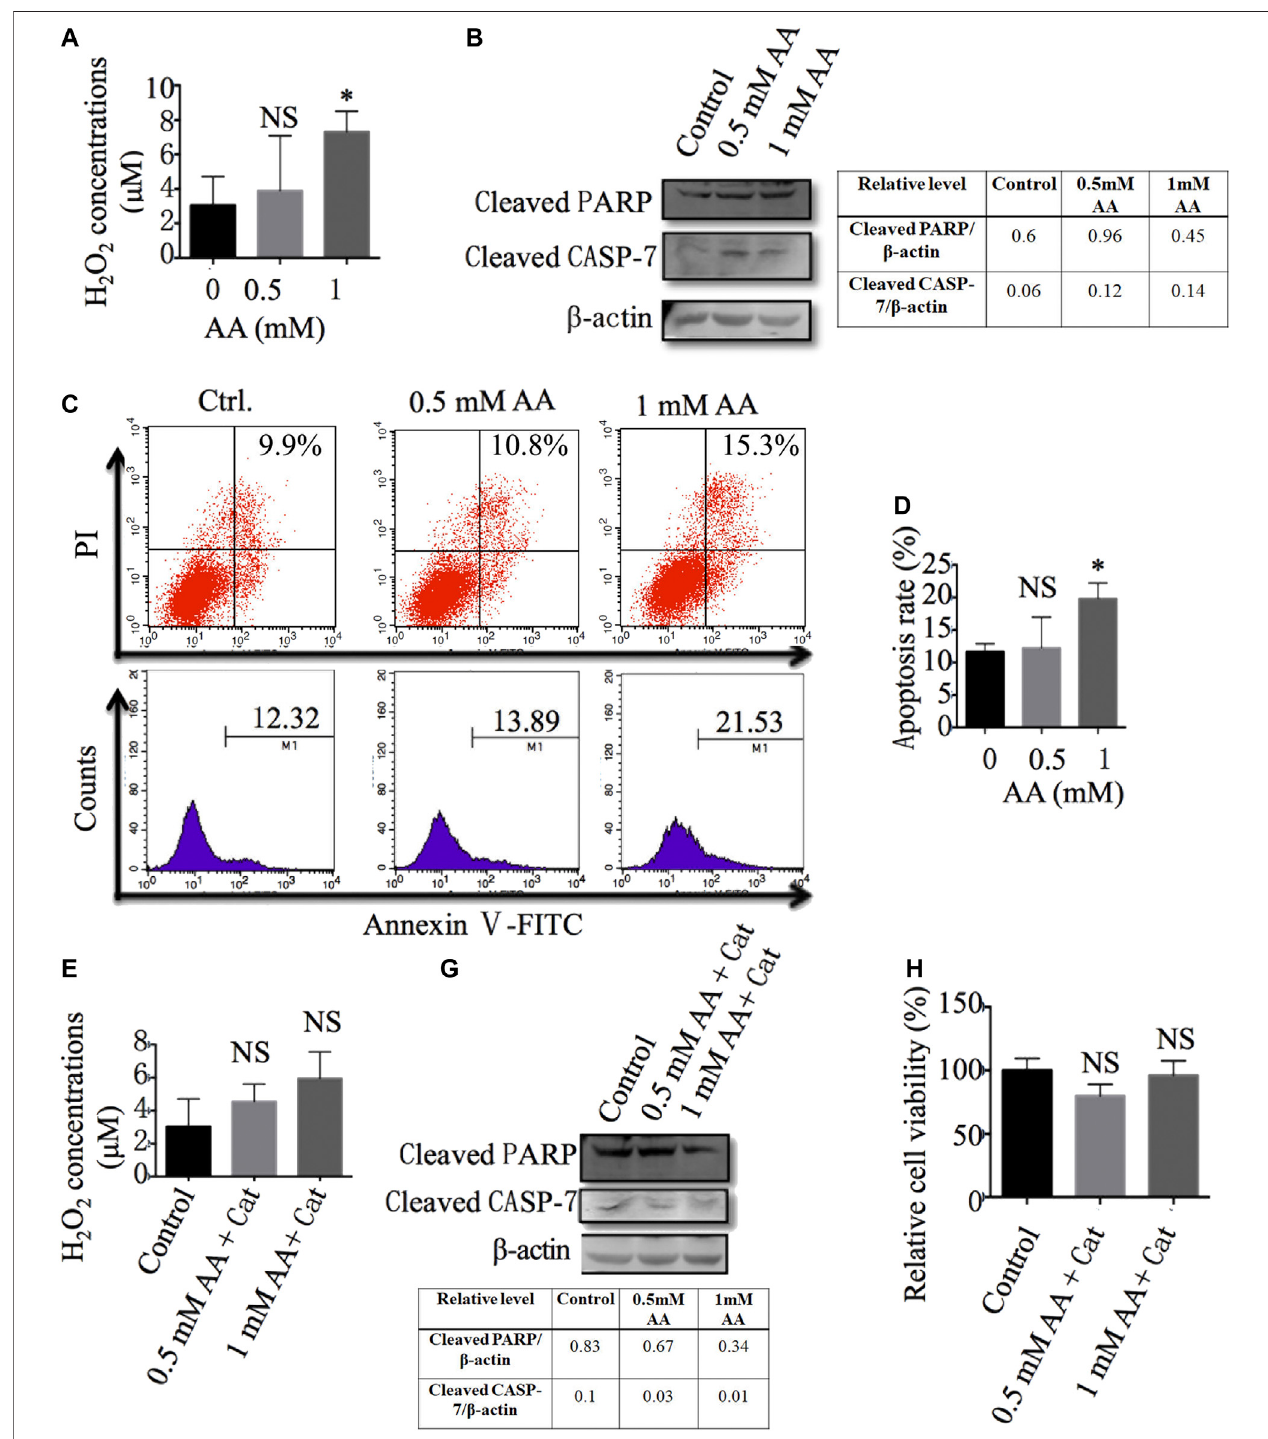
FIGURE7| AAreducesliverCSCviability via increasingtheproductionofH2O2andinductionofcellapoptosis. (A) ThecontentofH 2 O 2 inHuh7stemcellstreated withdifferentconcentrationsofAA. (B) TheproteinlevelsofcleavedPARPandcaspase7inHuh7stemcellstreatedwithdifferentconcentrationsofAA. (C , D) Apoptosis of Huh7 stem cells treated with different concentrations AA. (E) The content of H 2 O 2 in Huh7 stem cells treated with different concentrations of AA in the presence of 100 μ g/mlcatalase(Cat:catalase,Sigma-Aldrich). (F) TheproteinlevelsofcleavedPARPandcaspase7inHuh7stemcellstreatedwithdifferentconcentrationsof AA in the presence of 100 μ g/ml catalase. (G) Viabilities of Huh7 stem cells treated with different concentrations of AA in the presence of 100 μ g/ml catalase. * p < 0.05.